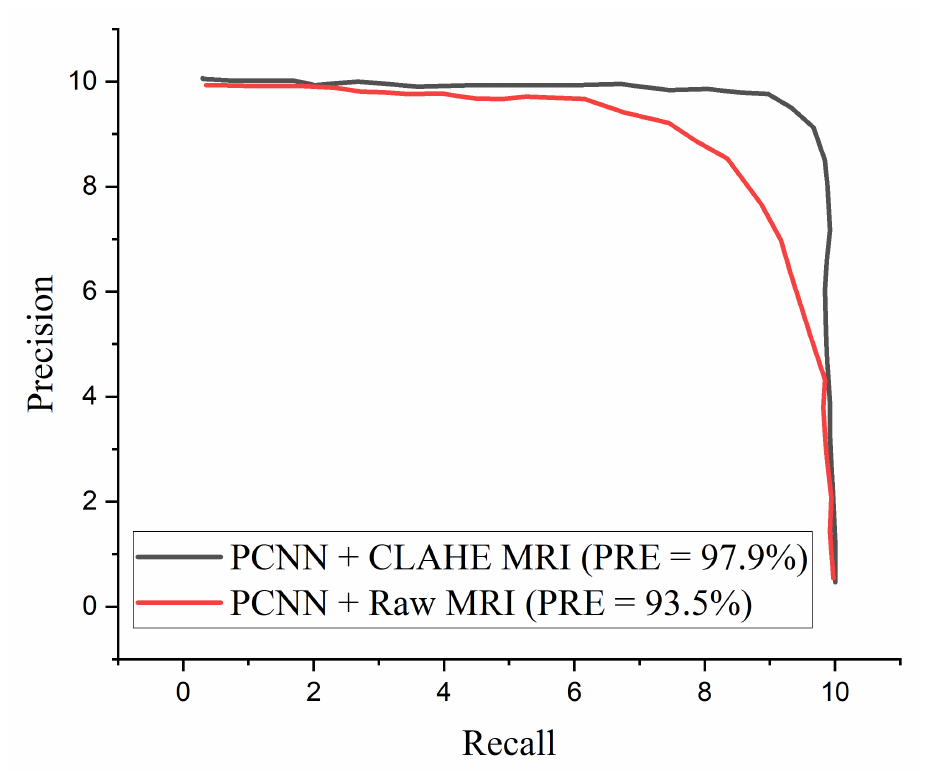
Figure 8. Precision–recall curves for the proposed PCNN in comparison with raw MRI and CLAHE pre-processed MRI